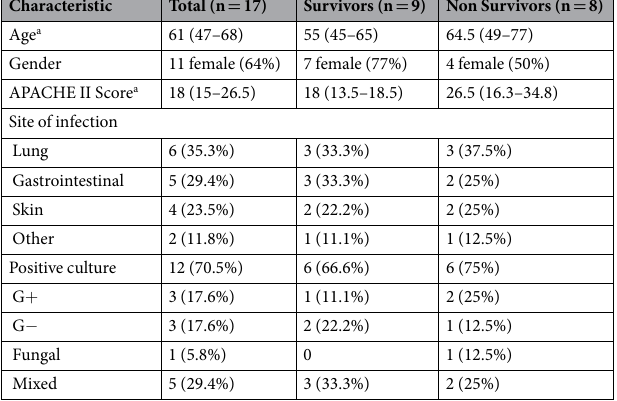
Table 1. Patient cohort characteristics. Unless otherwise stated, data has been represented as: number of patients (percentage of n). a Data represents median (interquartile